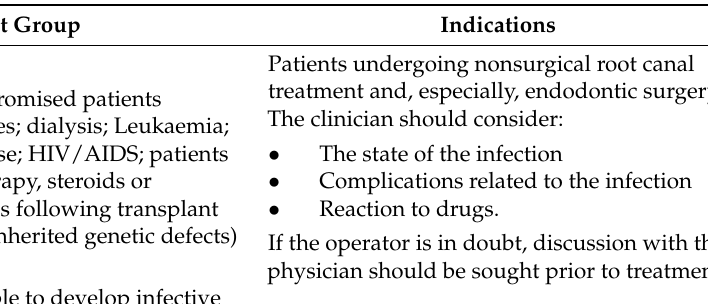
Table 4. Antibiotic prophylaxis in endodontics according to the European Society of Endodontology position statement: the use of antibiotics in endodontics